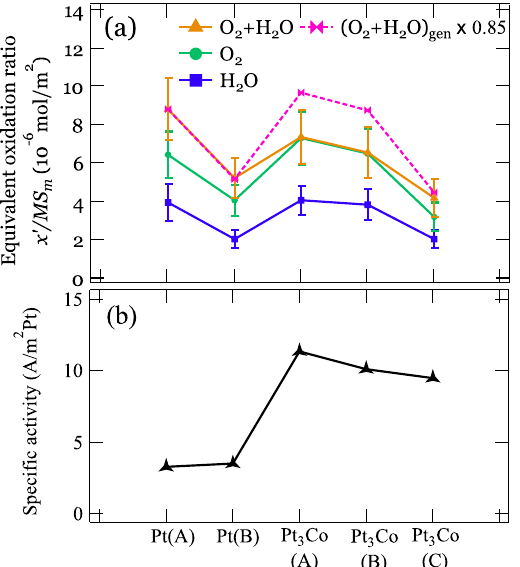
Figure 6. The comparison of ( a ) Equivalent oxidation ratios in different in situ conditions and ( b ) Specific activities for all the samples. The curves in ( a ) show the trends of H 2 O, O 2 and O 2 + H 2 O adsorptions against different samples. The 1:1 sum of the spectra for O 2 and H 2 O adsorption with a reduction factor of 0.85 were presented for references comparing to the equivalent oxidation ratio for the O 2 + H 2 O